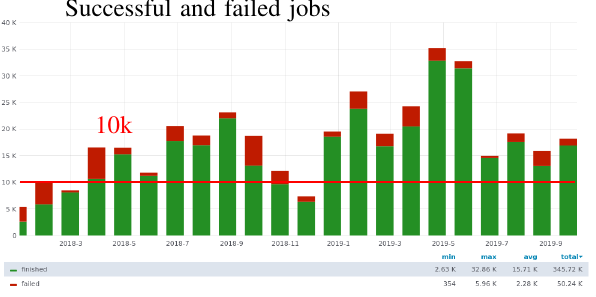
Figure 6. Number of finished (green) and failed (red) jobs. The failure rate is stable and relatively